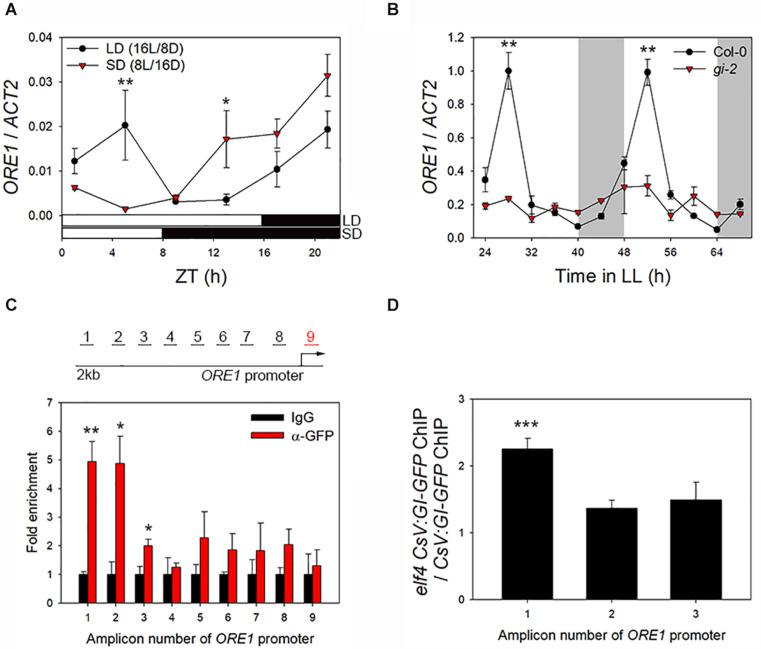
GI binds to ORE1 promoter and activates its expression. (A) Diurnal expression of ORE1 under long-day (LD; 16 h light/8 h dark) and short-day (SD; 8 h light/16 h dark) photoperiod. (B) Abundance of ORE1 mRNA in wild-type and gi-2 mutant leaves under continuous light (LL). White bars indicate subjective day, and gray shading indicates subjective night. (C)
ORE1 promoter-binding affinity of GI in CsV:GI-GFP transgenic plants. Schematic representation of amplicons 1–9 of the ORE1 promoter amplified in the chromatin immunoprecipitation-quantitative PCR (ChIP-qPCR) assay are indicated. Amplicon 9 was used as an internal control. Leaves were harvested at 12 h after light on. Fold enrichment indicates the ratio of chromatin immunoprecipitated using anti-GFP antibody to that immunoprecipitated using anti-IgG antibody. Asterisks indicate statistically significant difference compared with the IgG control. (D)
ORE1 promoter-binding activity of GI in the elf4 mutant relative to that in the wild type at amplicons 1, 2, and 3. Three biological replicates were performed. Asterisks indicate significant differences (*p < 0.05, **p < 0.01, ***p < 0.005; Student’s t-test).